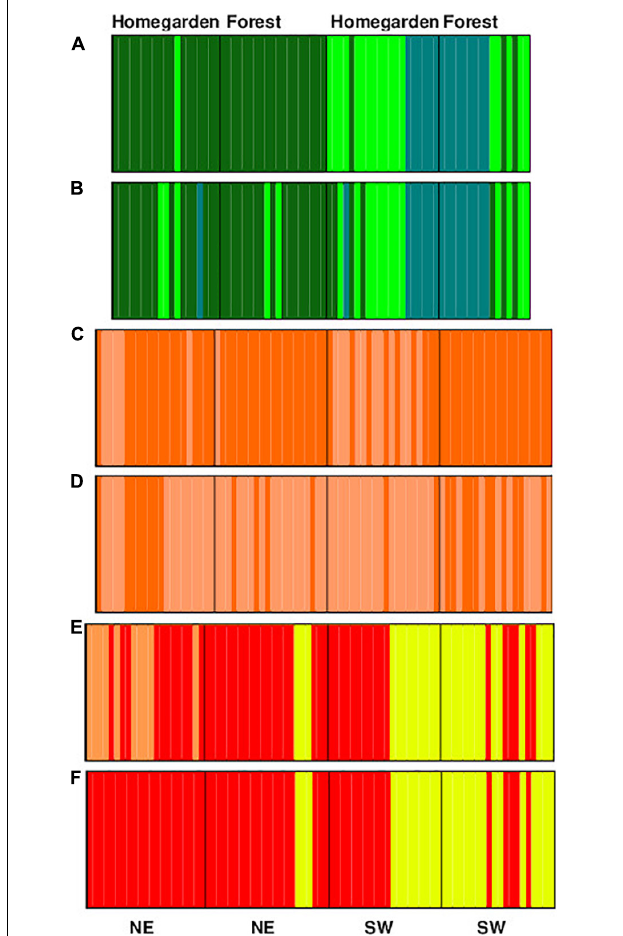
FIGURE 4 | Probability of assignment to the K groups for the Bayesian approach considering as prior geographic distribution (A,C,E) and for the K-means approach (B,D,F) . Individuals were grouped for each of the four combinations (region/population type) for Brosimum alicastrum (A,B) , Cordia dodecandra (C,D) , and Spondias purpurea (E,F)